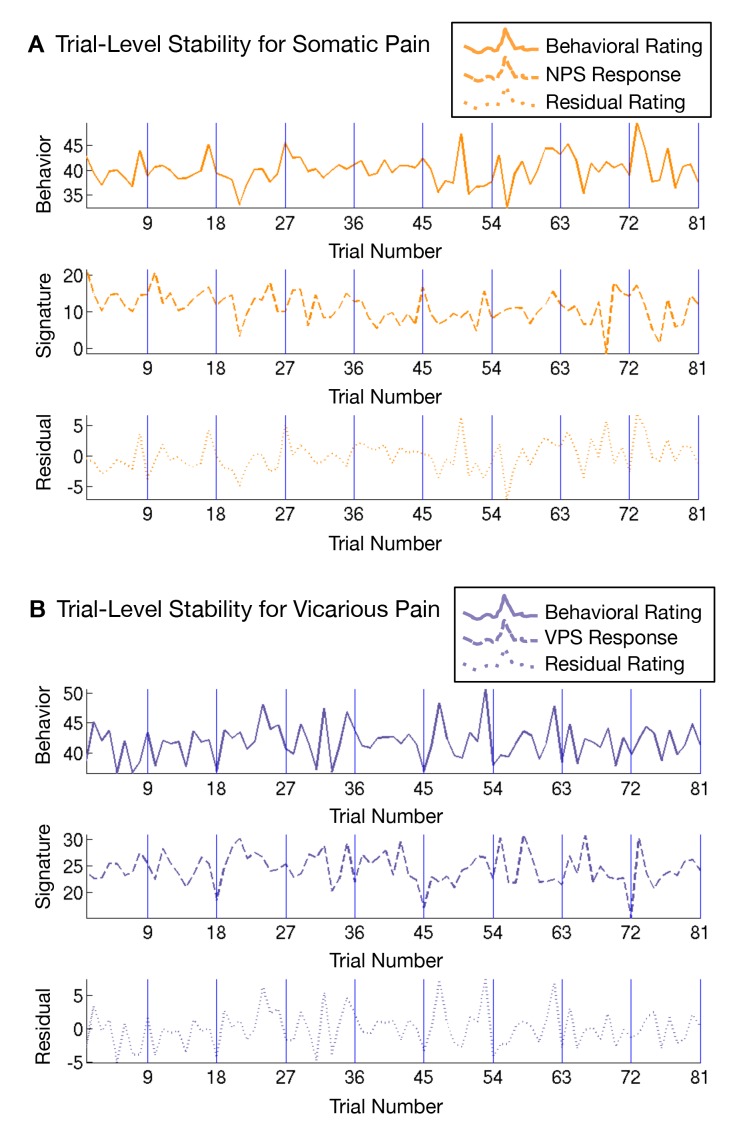
Trial-level stability of the NPS and VPS responses across all trials.The first row depicts subjective ratings for somatic pain (top panel) and vicarious pain (bottom panel) respectively, the second row depicts the ratings predicted by NPS (top panel) and VPS (bottom panel) respectively, and the third row shows the residual rating variance not predicted by the NPS (top panel) and VPS (bottom panel) respectively.